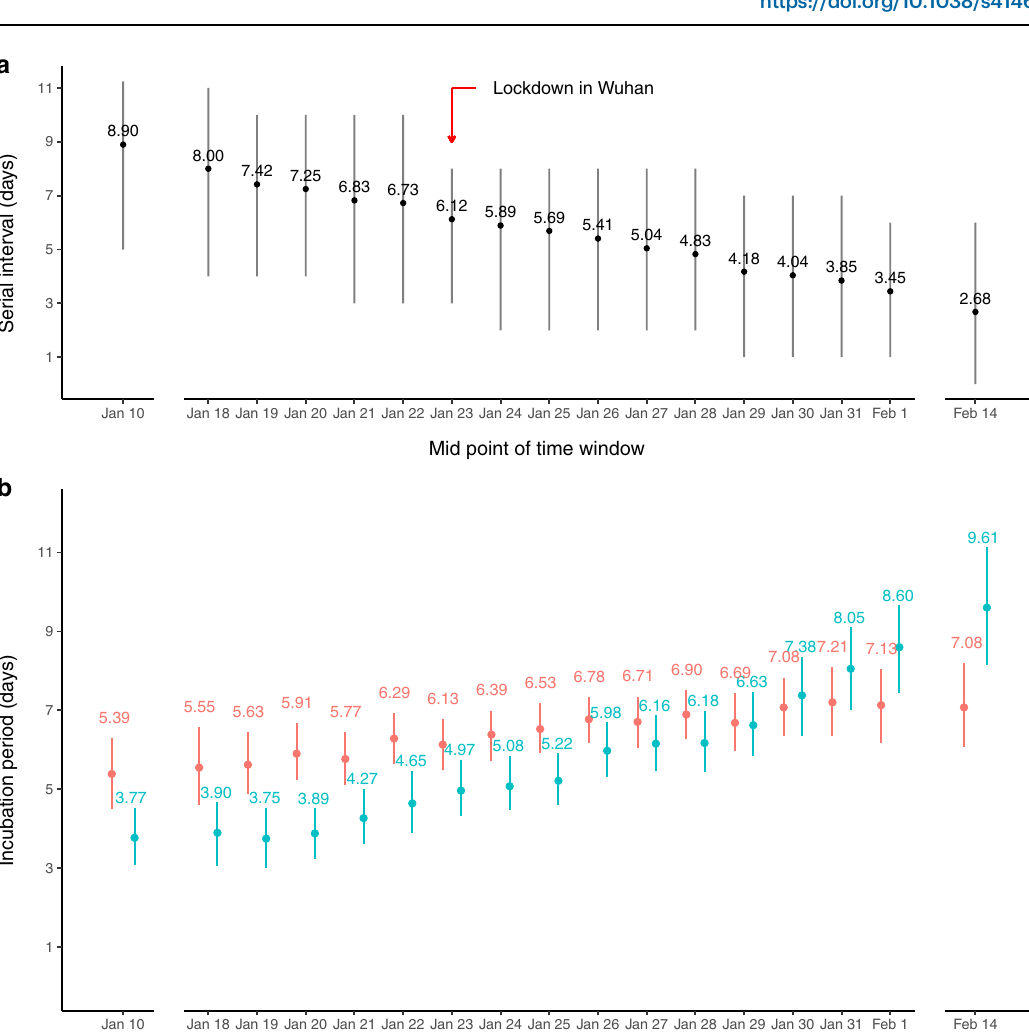
infectors (in teal). The dots and segments indicated the mean estimates and the corresponding 95% con fi dence intervals (CIs). Sample size (number of infectors with complete exposure information) in each time window (X-axis from left to right)forestimatingmeansand95%CIsofinfector ’ sIPreferencedbyinfectoronset: 25,21,24,32,36,41,44,47,51,61,59,52,50,46,43,37,34,respectively.Samplesize (numberofinfecteeswithcompleteexposureinformation)ineachtimewindow( X - axisfrom leftto right) for estimating means and 95%CIs of infectee ’ s IP referenced byinfectoronset:62,62,90,118,134,147,155,167,173,176,157,145,123,110,87,76, 70,